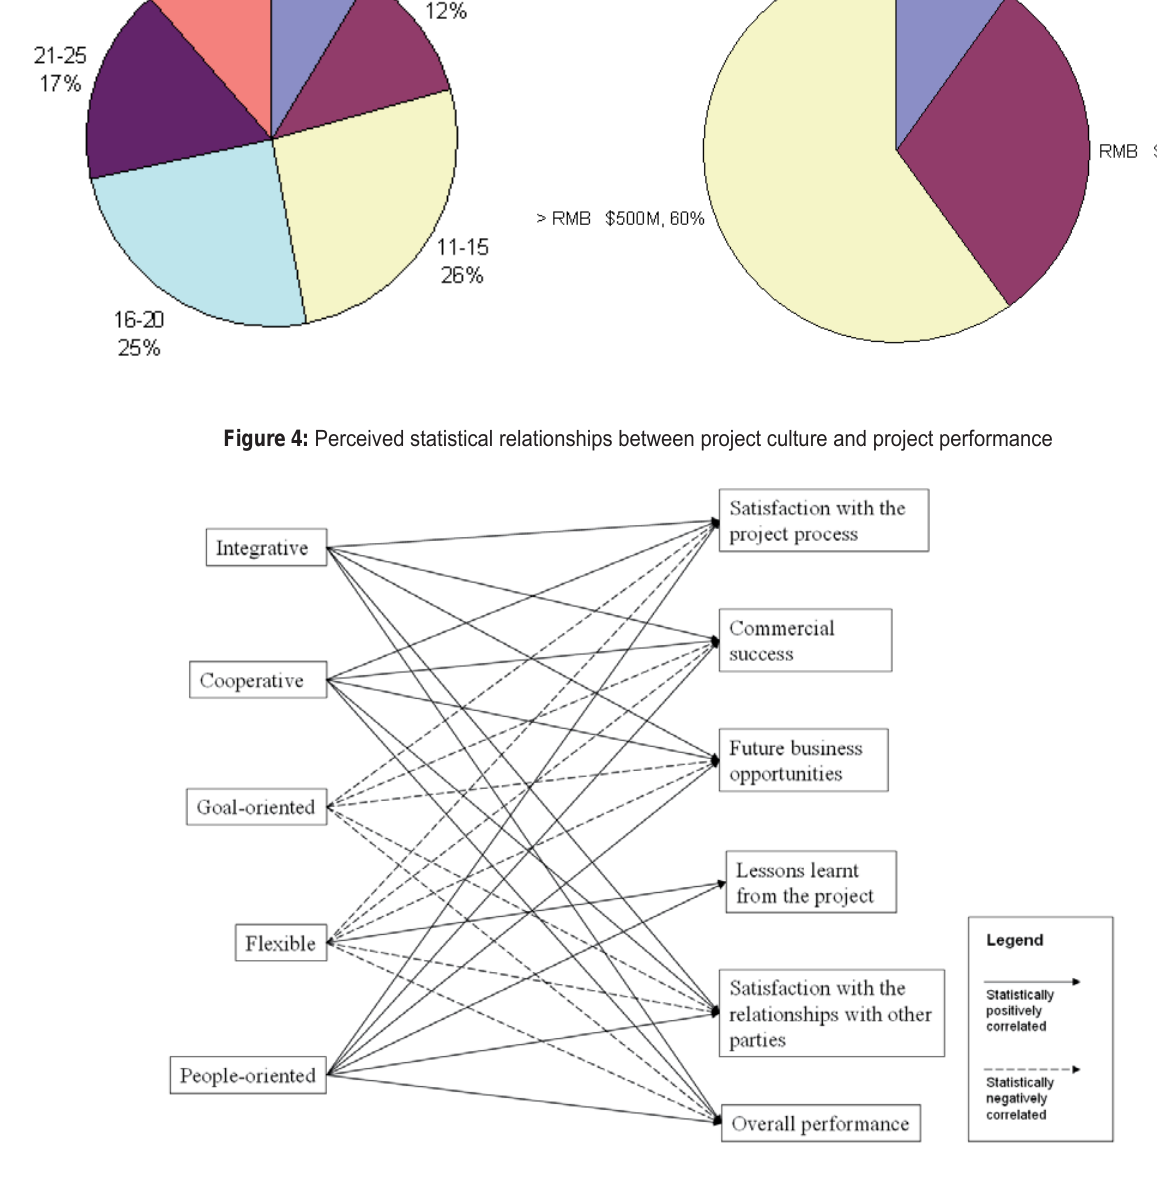
Figure 2: Experience of respondents (years)